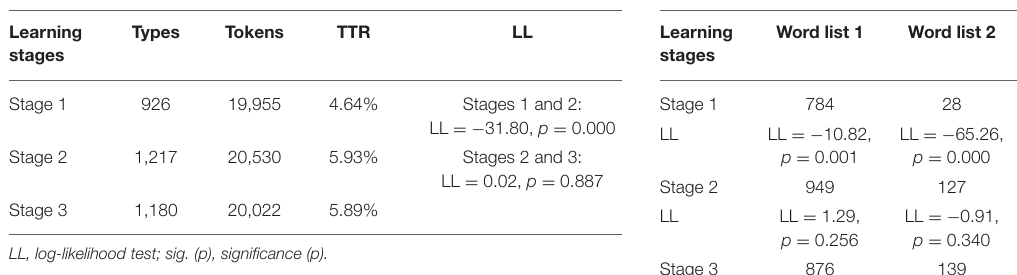
TABLE 3 | Type-token ratio (TTR) per learning stage. TABLE 4 | Number of word types per word list and per learning stage.